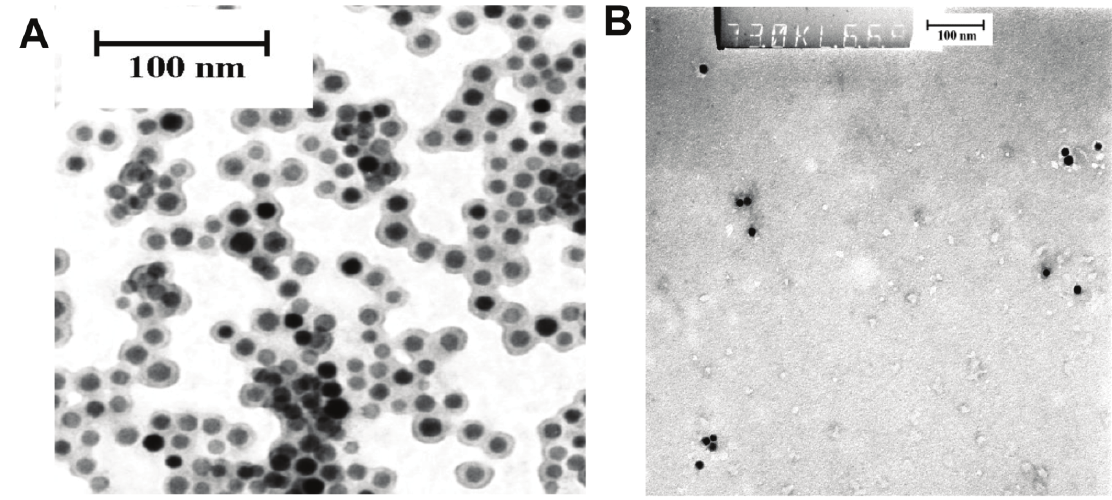
of the particles have been observed after incubation of 99m Tc-AF-SPIONs in human